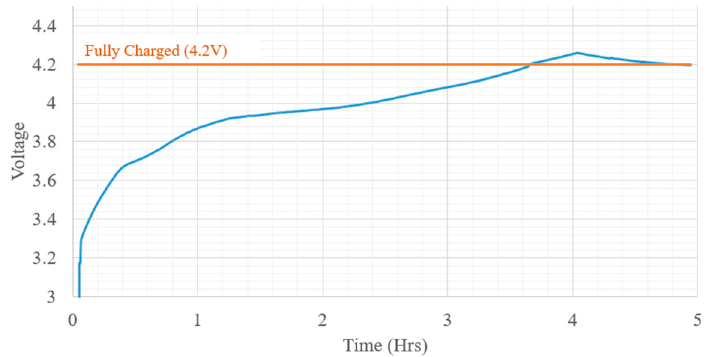
Figure 12. Battery charge waveform.